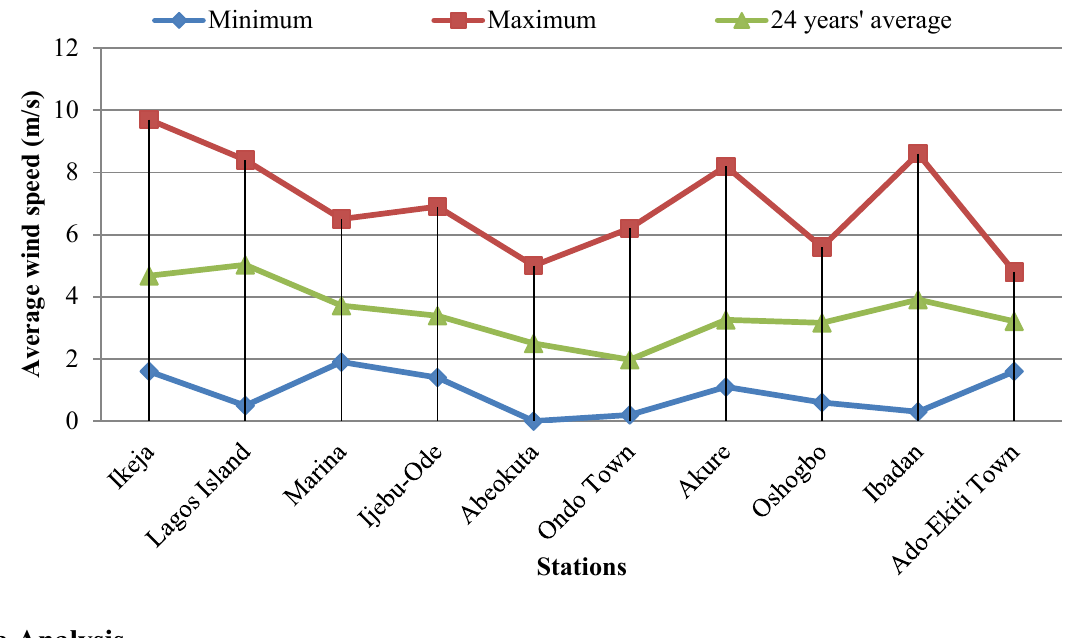
Figure 3. Range of wind speed and the stations’ 24 years’ average